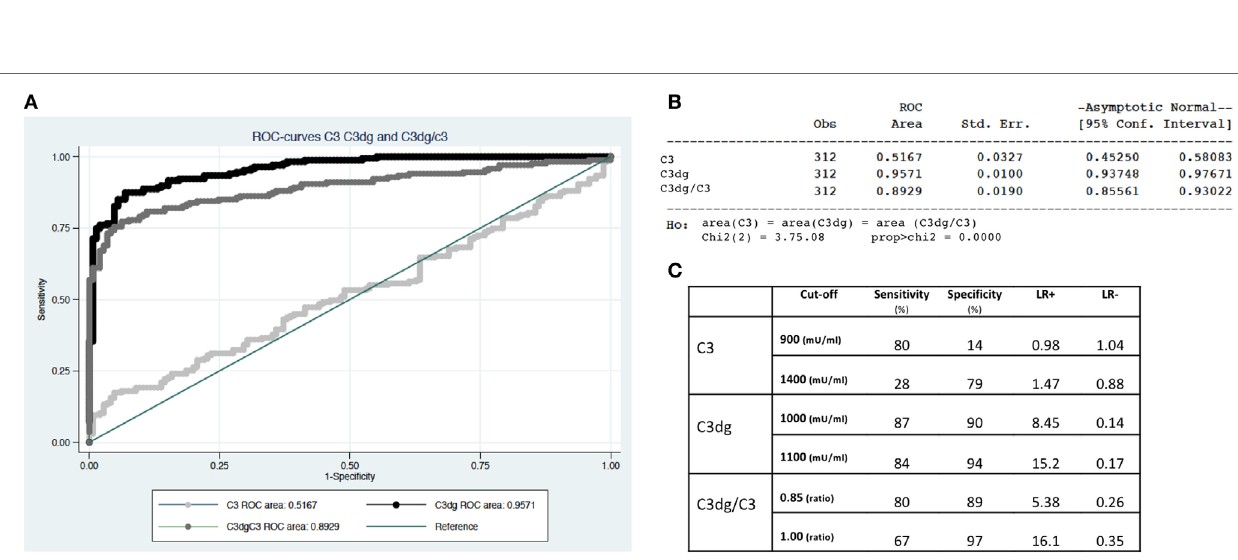
FigUre 5 | Separation of systemic lupus erythematosus patients from controls using C3, C3dg, and C3dg/C3. (a) demonstrates ROC-curves for C3 (light gray), C3dg (black), and C3dg/C3 (dark gray). (B) represents calculations of area under the curve with 95% confidence intervals for each of the curves in Figure 1B . (c) shows calculations of sensitivity, specificity, and likelihood ratios for C3, C3dg, and C3dg/C3 using two different cutoffs for each